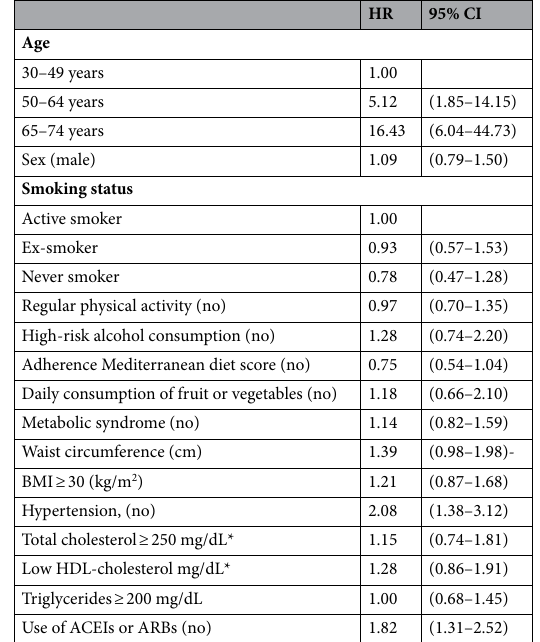
Table 3. Association risk of comorbidities and lifestyle factors with risk of IRF development. Model 1 (sex- and age-adjusted). *HDL-C of < 40 mg/dL in men or < 50 mg/dL in women.